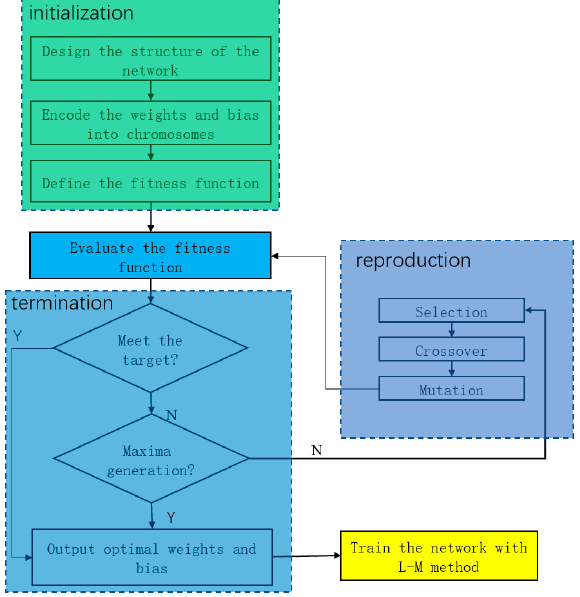
Figure 5. Flowchart for the genetic algorithm.